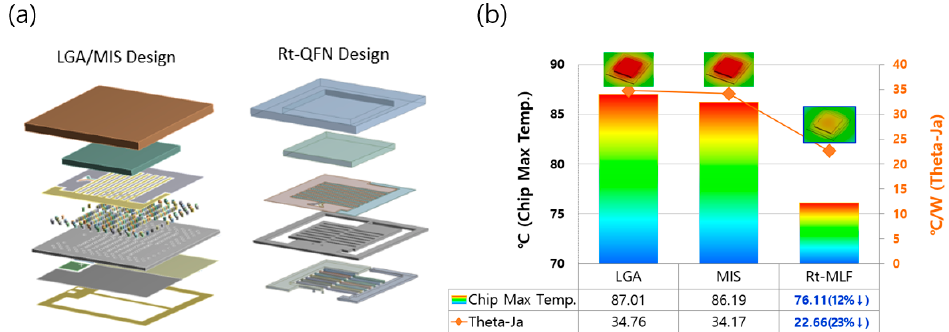
Figure 11. Comparison of heat dissipation performance between LGA and Rt-QFN substrate: ( a ) Structure of LGA/MIS substrate and Rt-QFN substrate; ( b ) Heat dissipation performance.